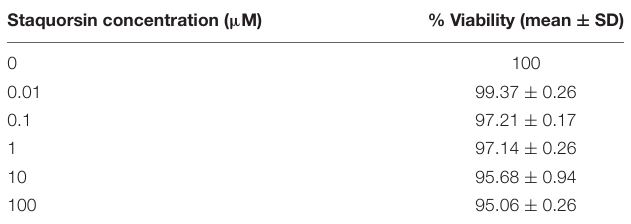
TABLE 3 | Results of the cytotoxicity assay on human skin fibroblasts. Staquorsin concentration ( µ